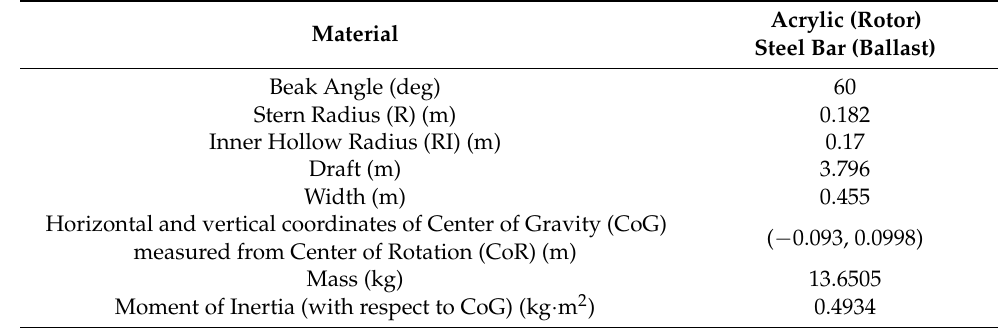
Table 1. Specifications of an asymmetric WEC (1/11